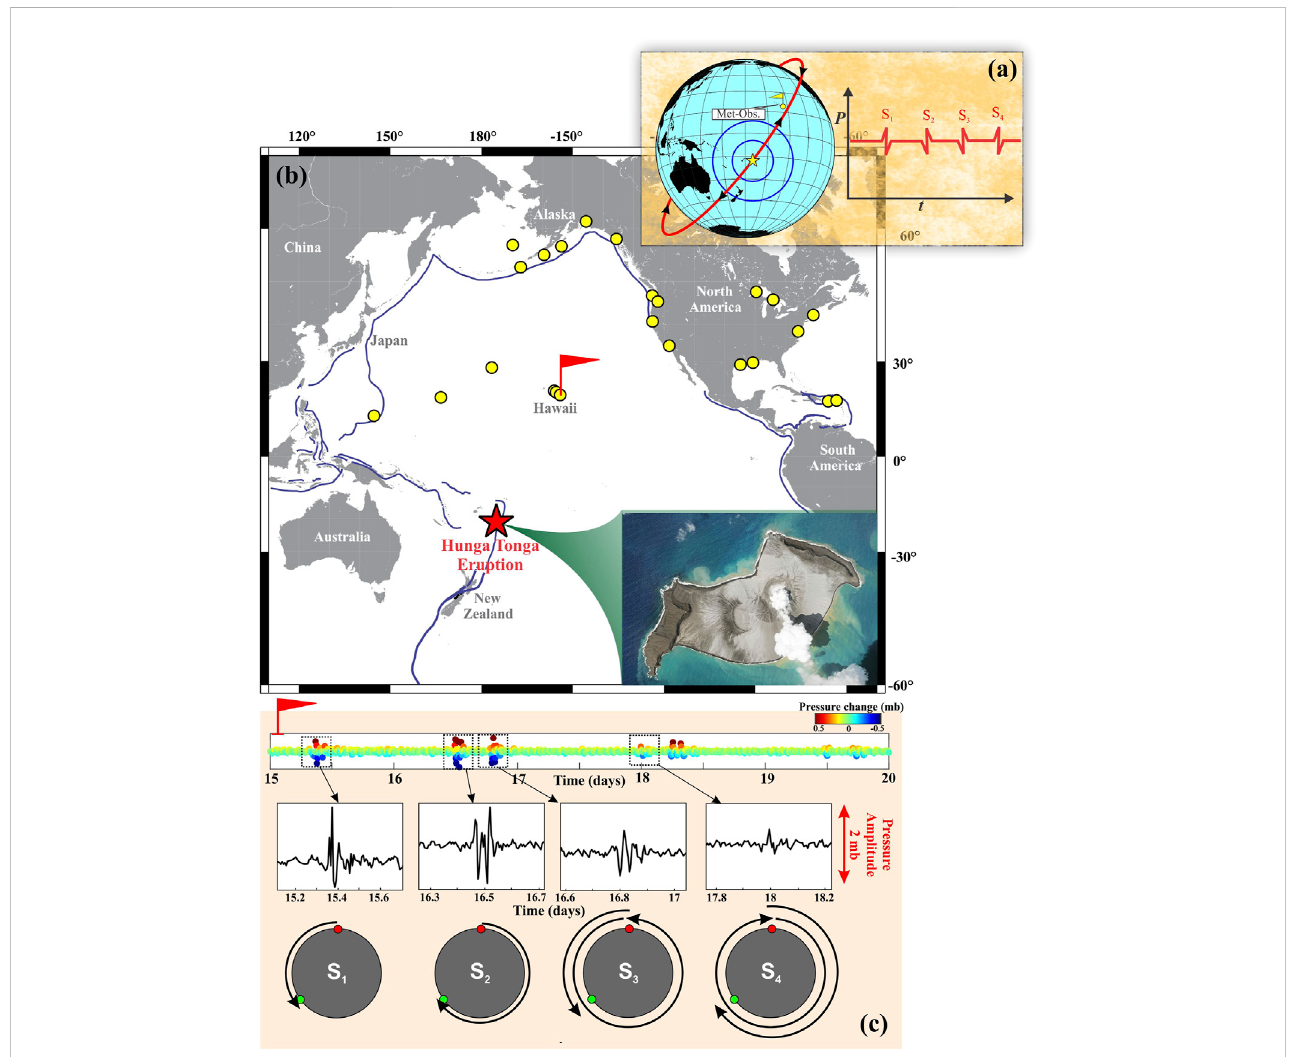
FIGURE 1 2022 HungaTonga volcanic eruption andatmosphericpressuredisturbance. (A) Schematicrepresentationof theLambwave, whichwas induced bythe volcanic eruption and traveled around the globe several times. Different meteorological stations recorded the atmospheric pressure changes at almost four signi fi cant phases. (B) Location of volcanic eruption and meteorological stations are marked by red star and yellow circles, respectively. Bottom panel shows aerial view ofbefore theeruption (taken from: PlanetLabs PBC/EYEPRESS/Shutterstock). (C) Representativeatmosphericpressure fl uctuation data from Kahului, Hawaii meteorological station (location represented in (a) by red fl ag), showing the four pressure fl uctuations (S 1 – S 4 ) from 15 – 19 January. Enlarged versions of four individual signals are shown in the middle panel. Lowest panel shows the representative travel path of the Lamb wave around the globe. Red dot represents the location of the volcano and green dot represents the station ’ s